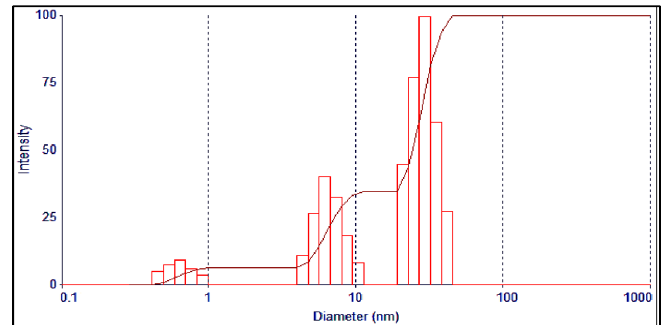
Figure 4. DLS analysis of the AgNPs.